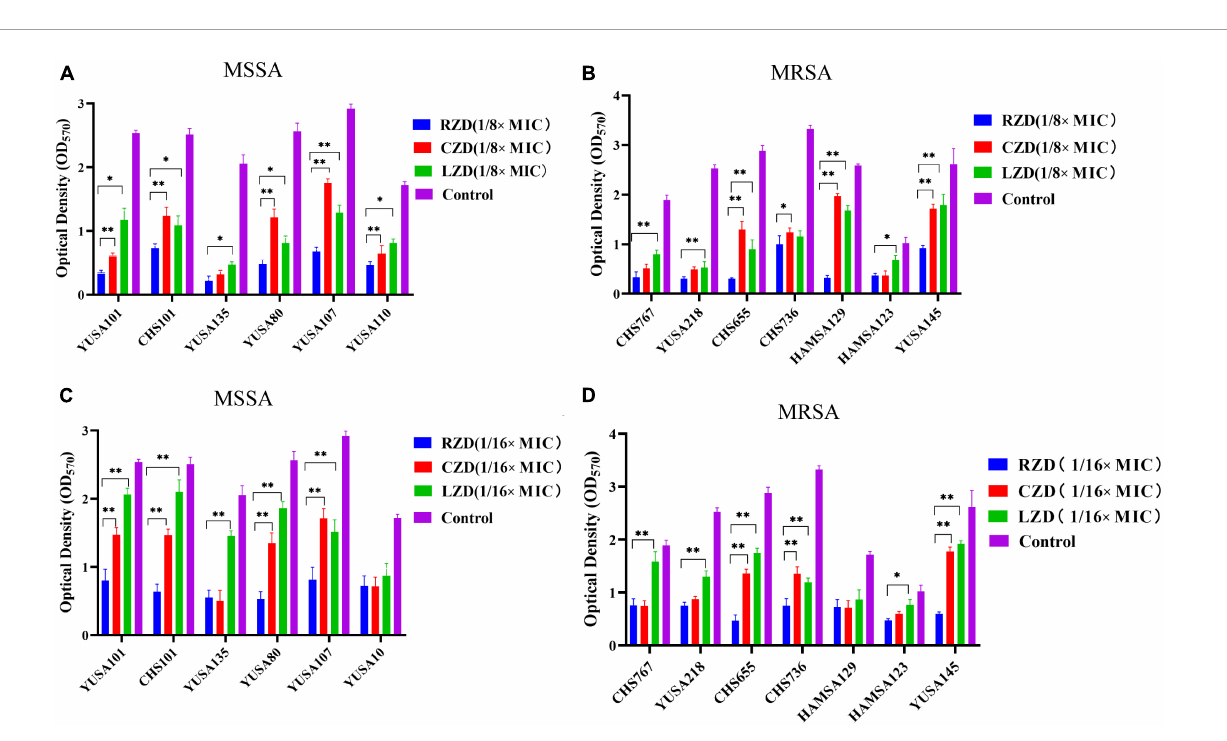
FIGURE3 The inhibitory effect of subinhibitory concentrations (1/8 × MIC and 1/16 × MIC) of radezolid, contezolid, and linezolid on biofilm formation. The anti-biofilm effect of radezolid, contezolid, and linezolid against MSSA (A) and MRSA (B) isolates was assessed at 1/8 × MIC. The anti-biofilm effect of radezolid, contezolid, and linezolid against MSSA (C) and MRSA (D) isolates was assessed at 1/16 × MIC. The presented data were the average of three independent experiments (mean ± SD). ∗∗ P < 0.001, ∗ P < 0.05 (Student’s t -test). MIC, minimum inhibitory concentration; RZD, radezolid; CZD, contezolid; LZD,